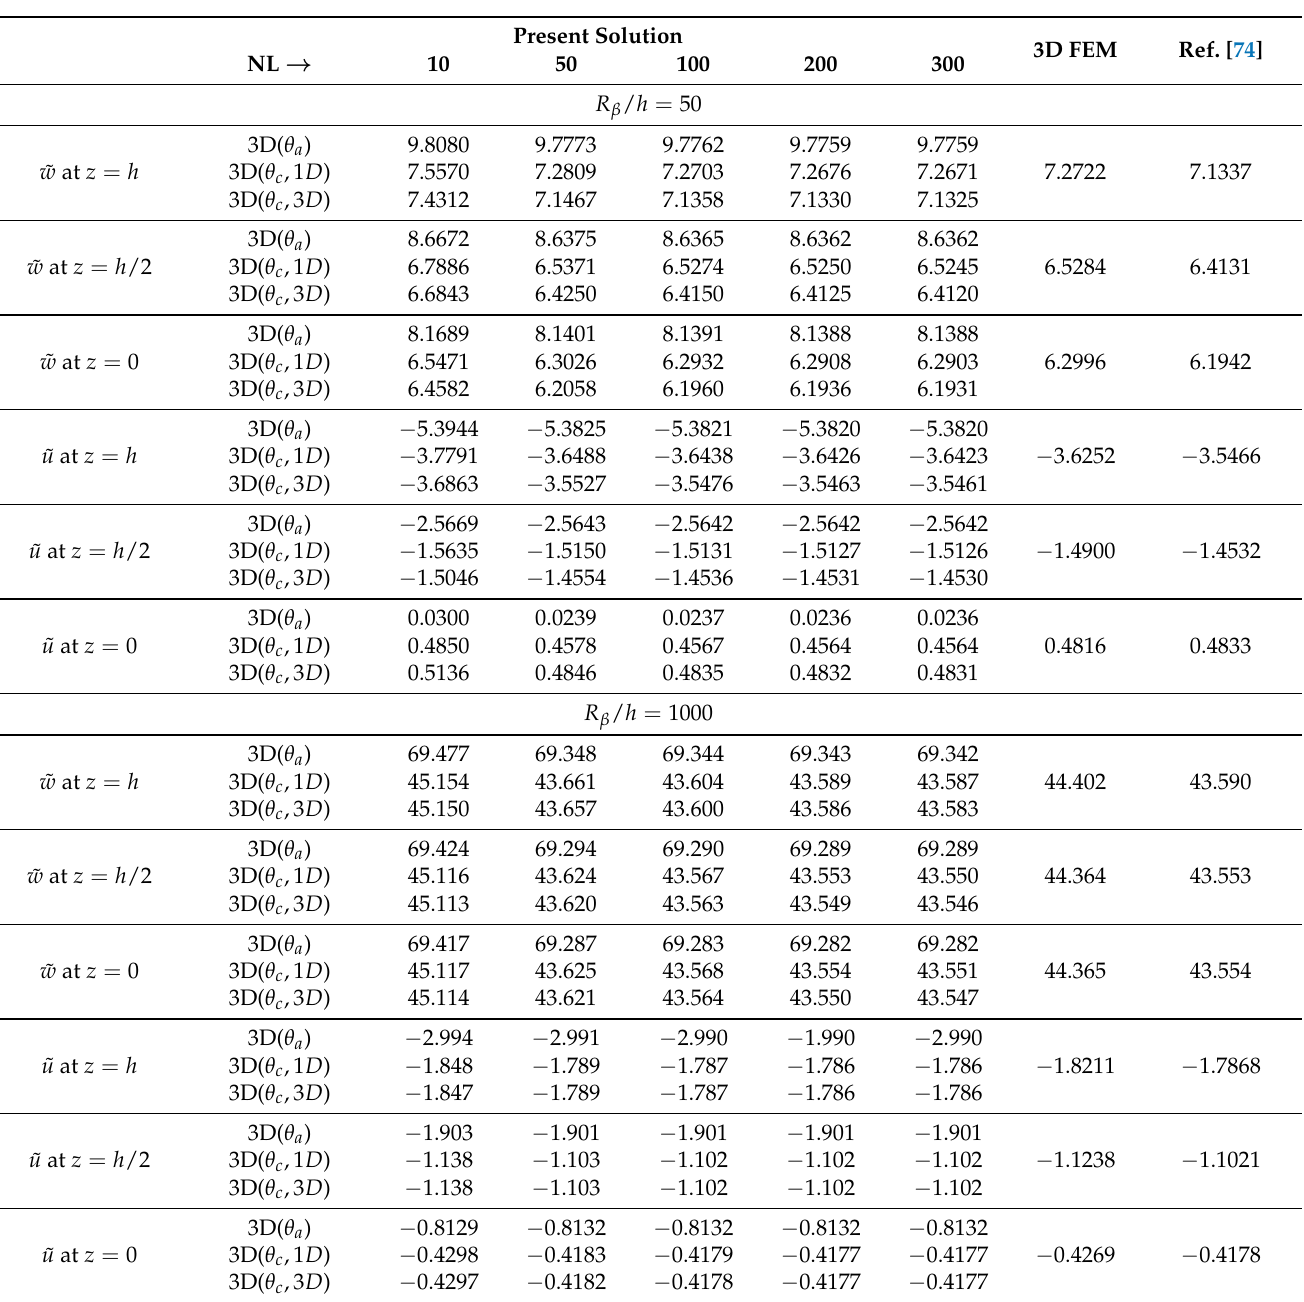
Table 3. Third assessment. One-layered FGM cylindrical shell ( R β = 10 m), featuring different thickness ratios. The volume fraction power law considers p = 2 as the exponent. An external sovra-temperature field acts on the top ( θ t = + 1 K) and bottom ( θ b = 0 K) surfaces; m = n = 1. The reference solution is a refined 2D layer-wise solution based on the Unified Formulation [74], considering a 3D temperature profile along with thickness direction. A 3D FE model is also assessed. The results of the present solution are obtained with N = 3 and for a varying number of mathematical layers NL. Present